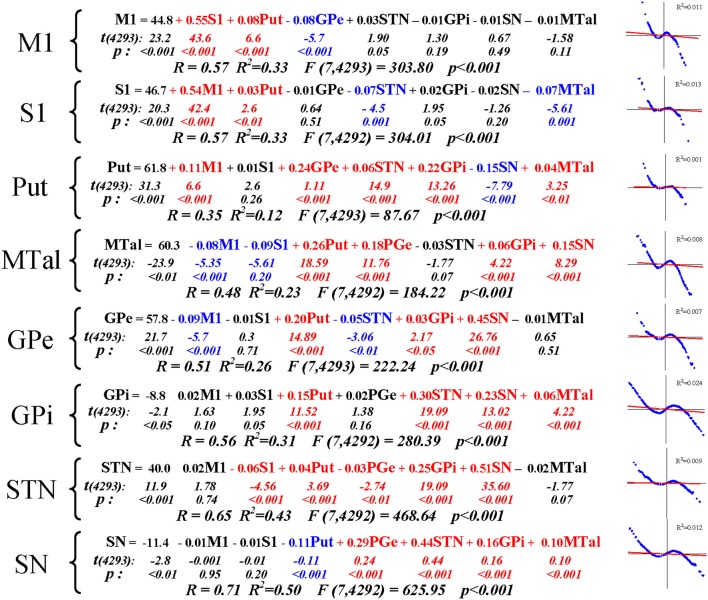
Multiple regression analysis of BG interactions. The distribution of residuals (values predicted by the regression equation minus observed values) regarding values expected according to a normal distribution of residuals (red line) are shown on the right of each regression equation. M1, primary motor cortex; S1, somatosensory cortex; Put, putamen; GPe, external globus pallidumN; STN, subthalamic nucleus; GPi, internal globus pallidum; SN, substantia nigral; MTal, motor thalamus; MTal; R, correlation coefficient; R2, coefficient of determination.